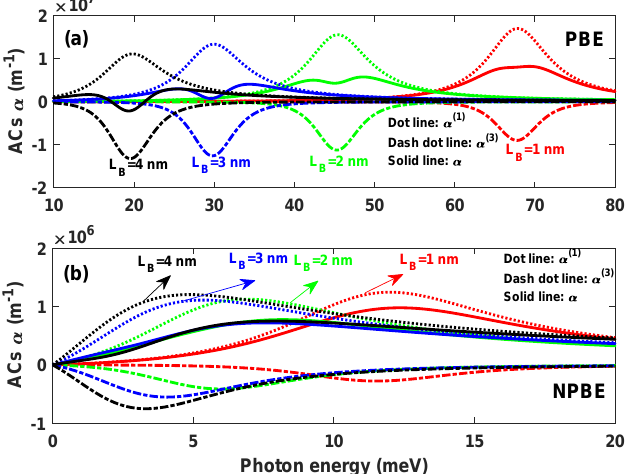
Figure 6. Variations of the linear α ( 1 ) ( ω ) , the third-order nonlinear α ( 3 ) ( ω ) and the total OACs α ( ω ) versus the photon frequency ¯ h ω with L L = L R = 8 nm, for two case: Without ( a ) and with ( b ) considering the influence of